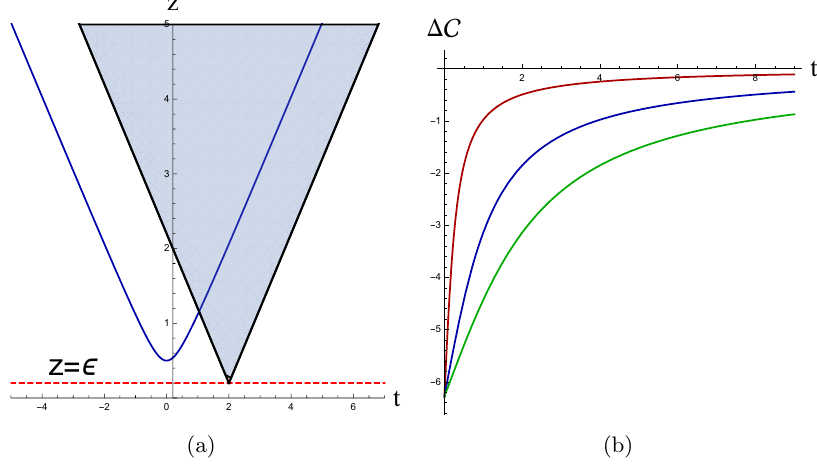
Figure 6 . In the left plot, we present the Wheeler-DeWitt patch corresponding to the holographic local quench setup. The blue curve is the massive particle trajectory, the red dashed line is the UV regulated boundary, and the black solid lines are the boundaries of the WDW patch. In the right plot, the time evolution of the action complexity is shown, (cid:11) = 0 : 5 ; 1 ; 2 from the bottom to the top respectively. One can see that instead of the unbouned growth (as in the CV case) the complexity returns to its unperturbed